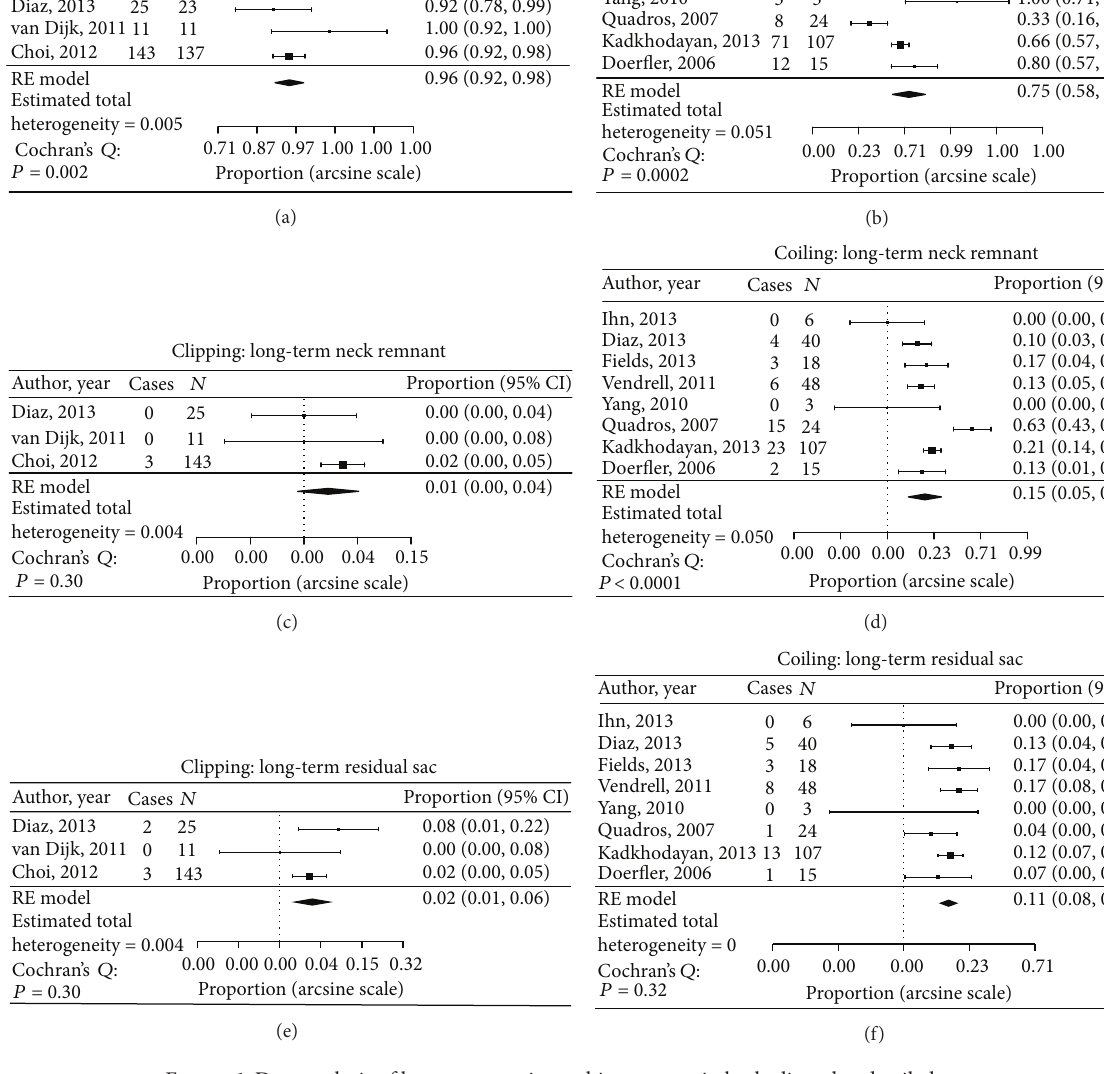
8.8% versus 4.6% versus 3.3%), and intraoperative rupture (4.1% versus 2.2% versus 1.9% versus 0.0%)